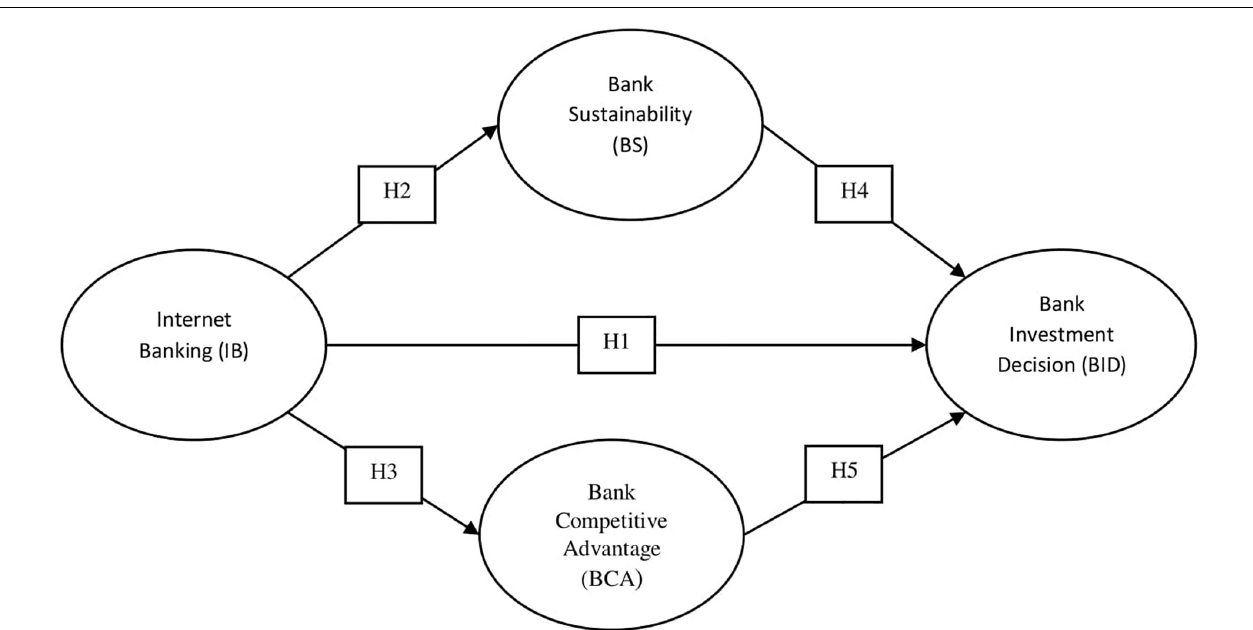
FIGURE 1 | Conceptual framework and the study’s